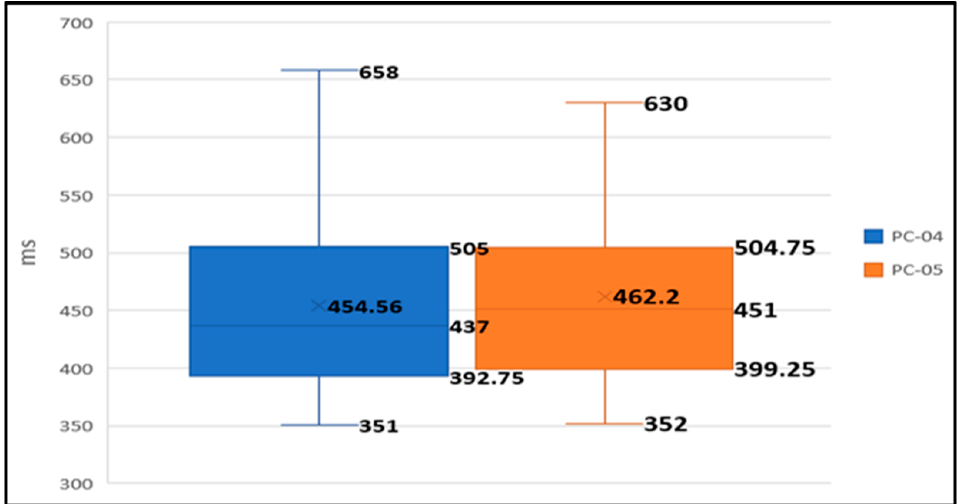
Figure 14. Cost of transaction propagation .